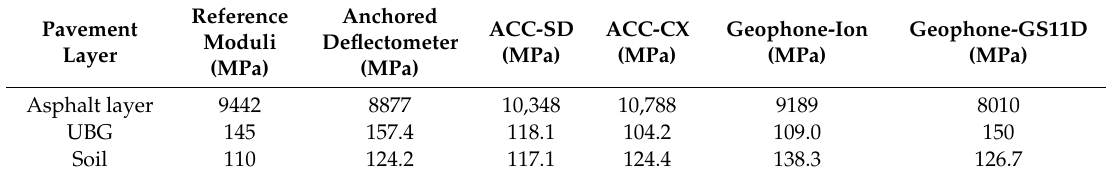
Table 5. Back-calculated pavement layer moduli obtained with ALIZE for the di ff erent sensors, and comparison with reference